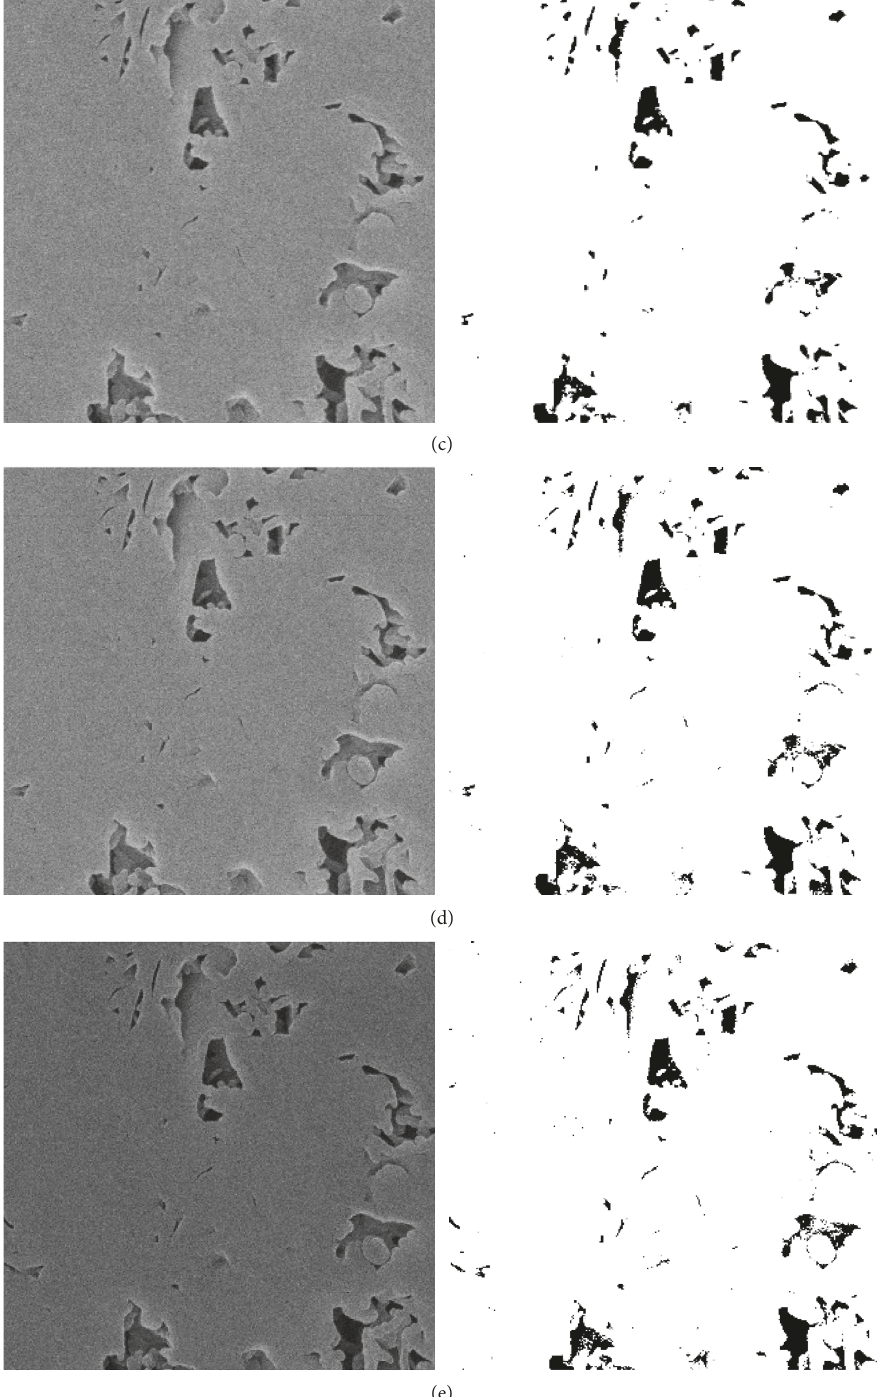
Figure 13: HIM images of zone 3 in H1 with decreasing resolution from 16nm to 1 nm: (a) resolution of 16 nm; (b) resolution of 8 nm; (c) resolution of 4nm; (d) resolution of 2nm; (e) resolution of